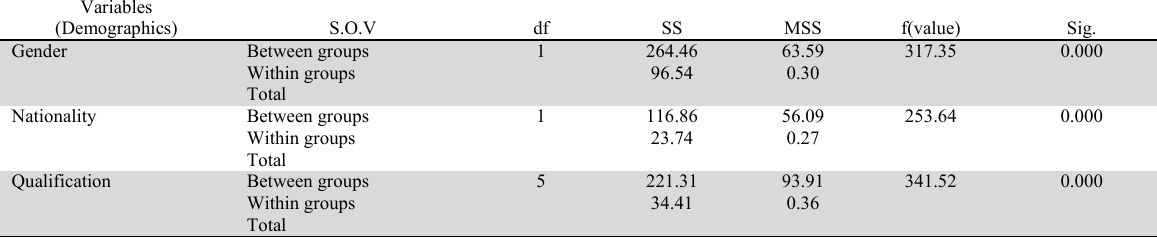
Results of the analysis of the uneven variation of the average of employees' satisfaction on the internal marketing policies and procedures applied in Prince Sattam bin Abdulaziz University according to the demographic